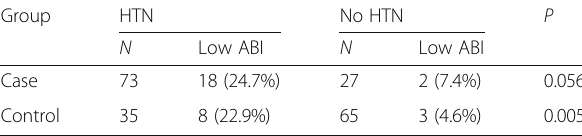
Table 2 Comparison of percent frequency for abnormal ABI in subjects with or without HTN in case and control groups Group